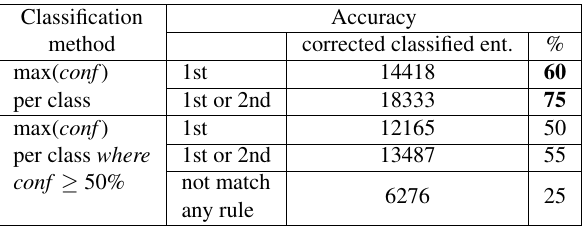
Table 2: General accuracy of the proposed